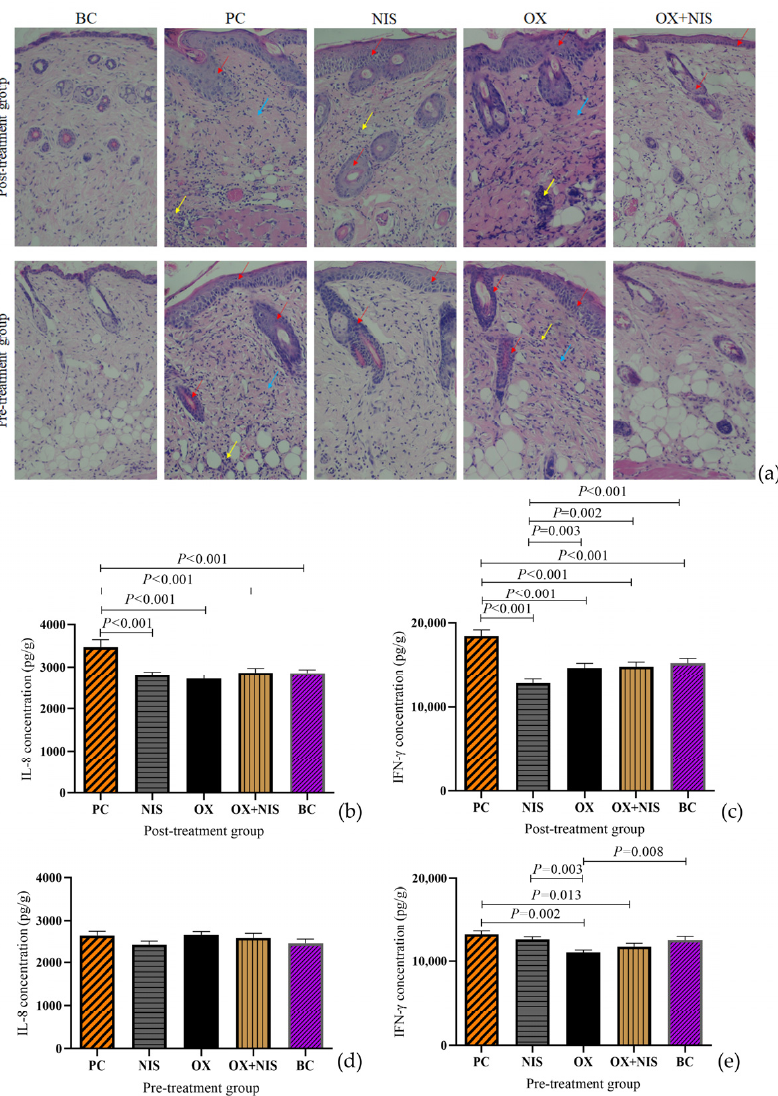
Figure 7. ( a ) E ff ects of post- and pretreatment of OX, NIS and OX + NIS on histopathological changes of MRSA infected skin wound (red arrow, cuticle; yellow arrow, in fl ammatory cell; blue arrow, histocyte); And the expression of IL-8 ( b , d ) and IFN- γ ( c , e ) in MRSA infected wound tissues in post-treatment ( b , c ) and pre-treatment ( d , e ) of OX, NIS and OX + NIS.